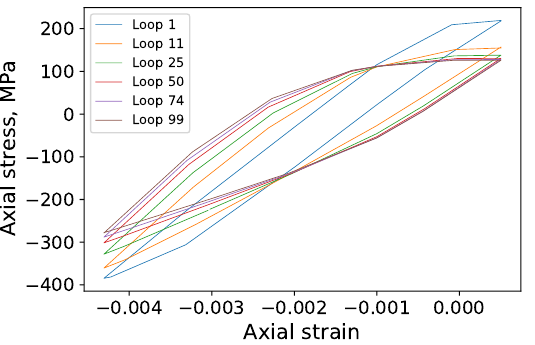
Figure 15. Behavior of the numerical model under constant cyclic loading (separate loops).